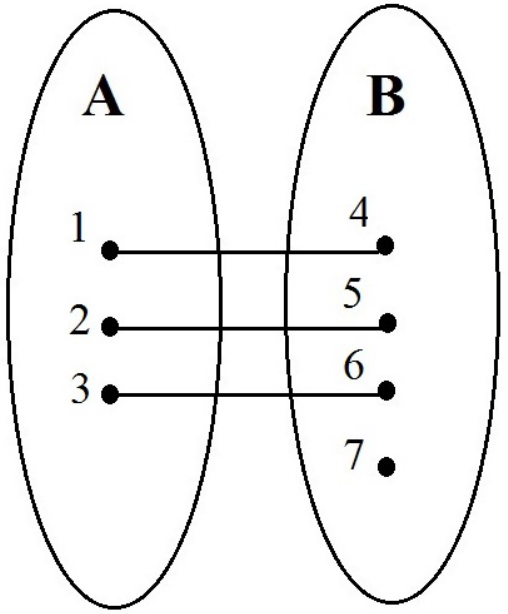
Figure 13. Each vertex from B is not included in some packings, so x 4 = . . . = x 7 = 0, and x 1 = x 2 = x 3 = 1.